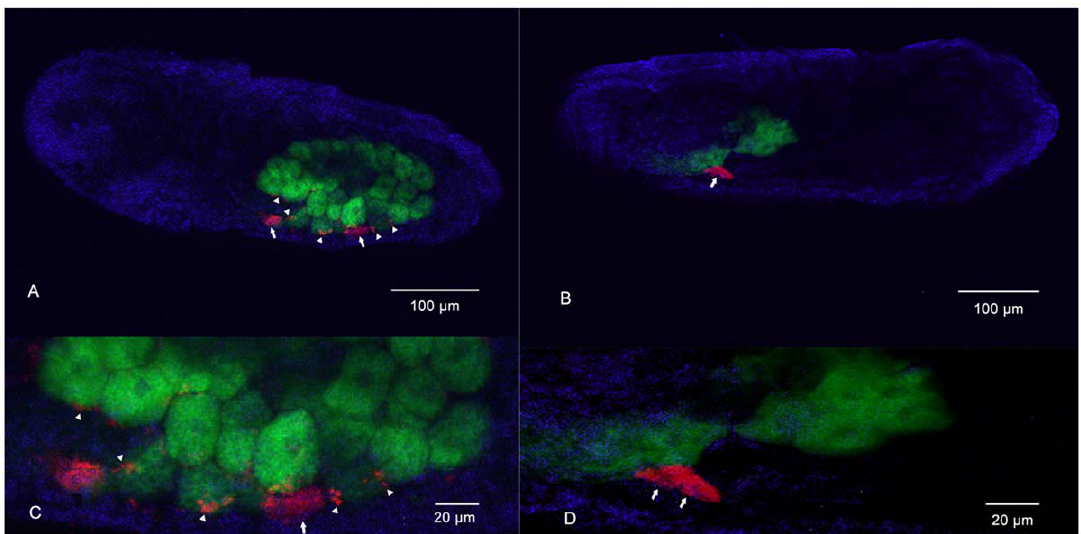
Figure 2. Whole-mount insitu hybridization of aphid embryos. Buchnera aphidicola (green), SMLS (red) and nuclei of aphid cell (blue). A, B, sheath cells and secondary bacteriocytes harbouring SMLS and primary bacteriocytes harbouring B. aphidicola . C, D, magnified images of A and B. Arrows, secondary mycetocytes; arrowheads, sheath cells.